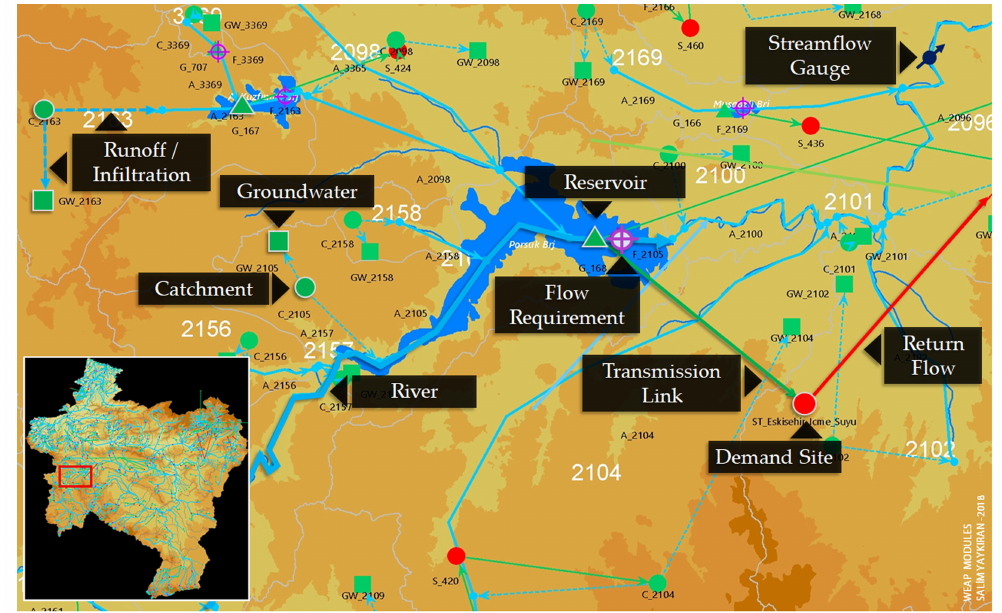
Figure 7. Representation of the Sakarya River Basin’s WEAP-PGM